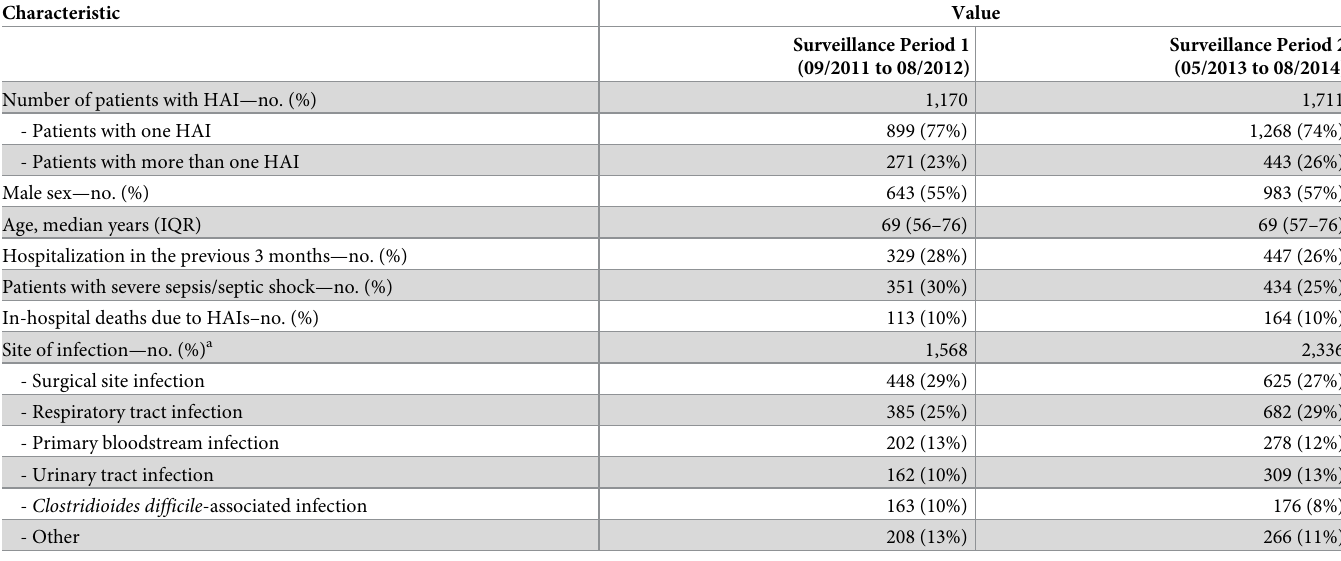
Table 1. Selected characteristics of patients in the ALERTS study (for details, see Hagel et al.